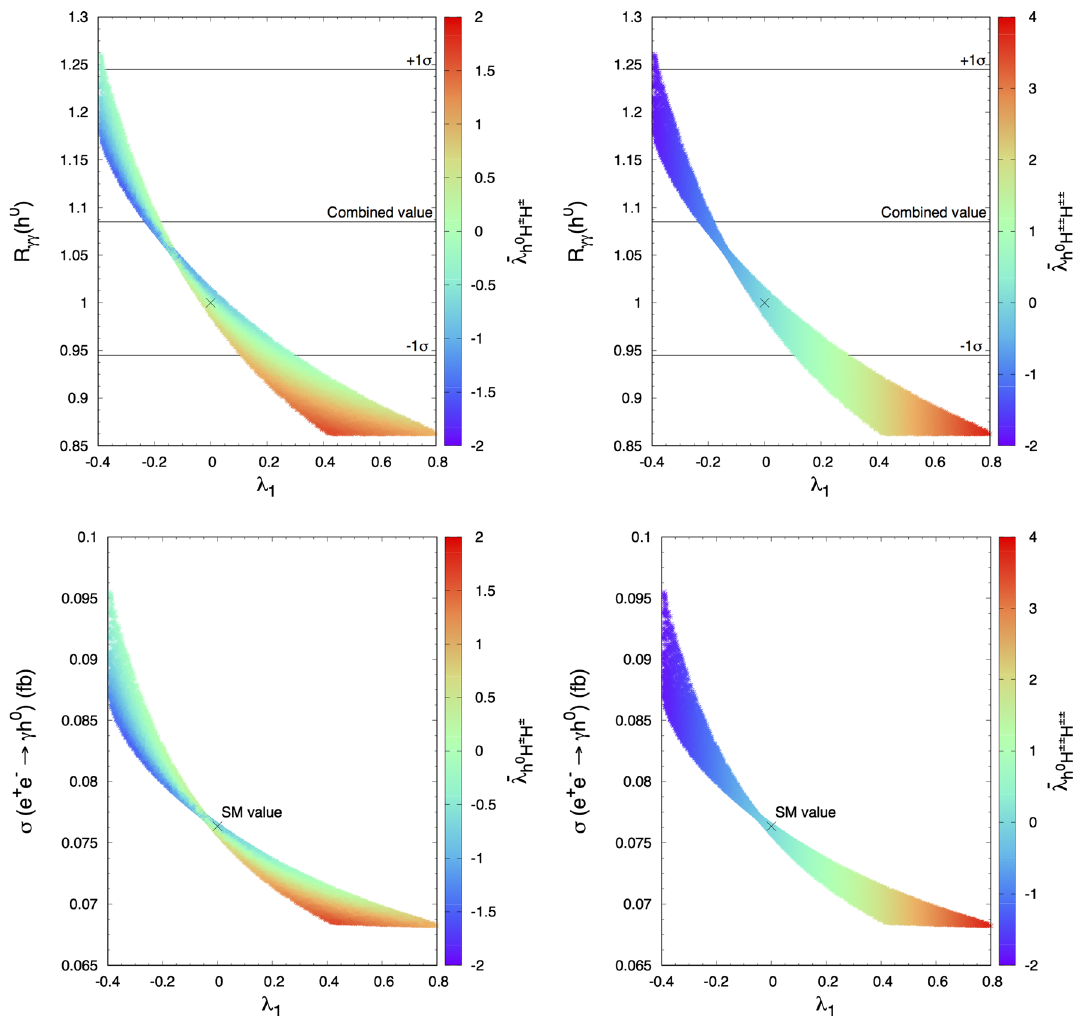
Fig. 5 Signal strength R γγ ( h 0 ) (upper panels) and σ( e + e − → γ h 0 ) √ s = 250 GeV (lower panel) as a function (fb) total cross section for of λ 1 coupling. The other inputs are λ = 0 . 517 ( m h 0 = 125 . 09 GeV), λ = 2 λ = 0 . 2, − 1 . 2 ≤ λ ≤ 0 . 8, v Δ = μ = 1 GeV. Horizontal lines 3 2 4